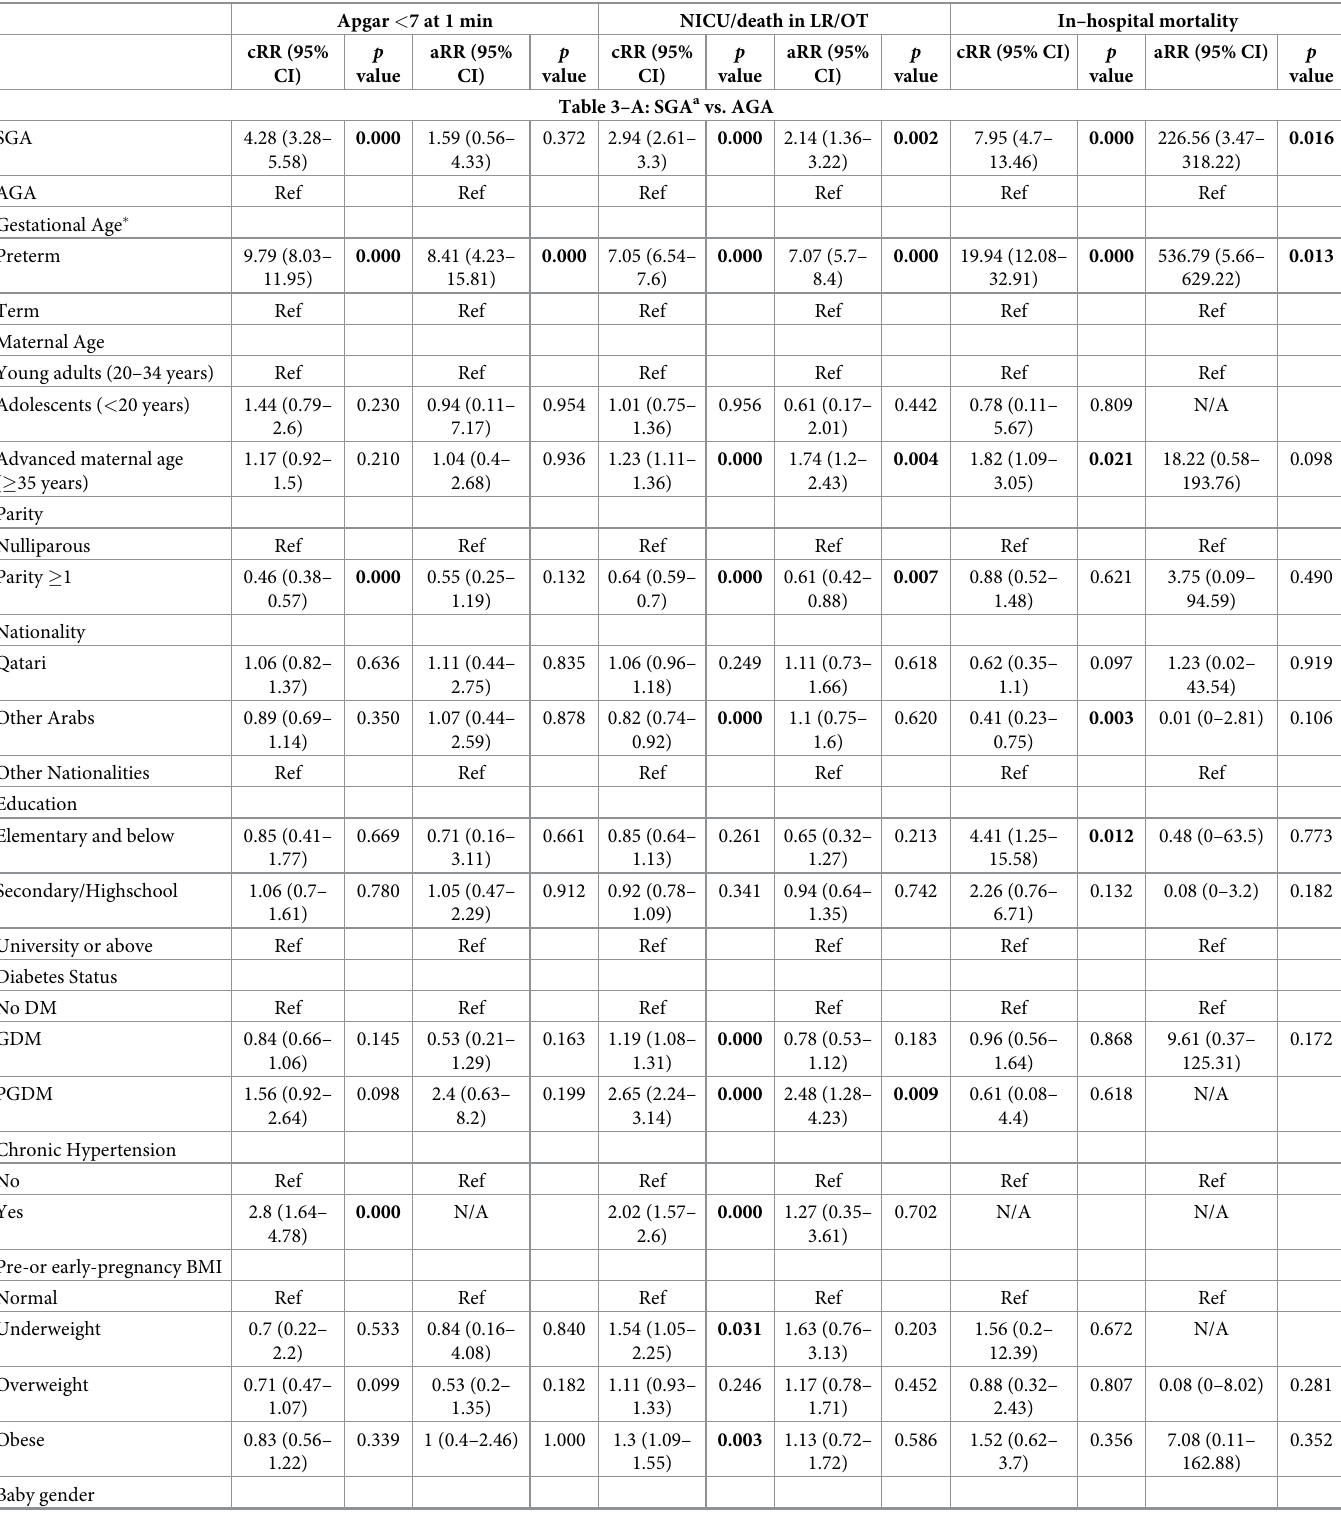
Table 3. Outcomes associated with SGA and LGA.